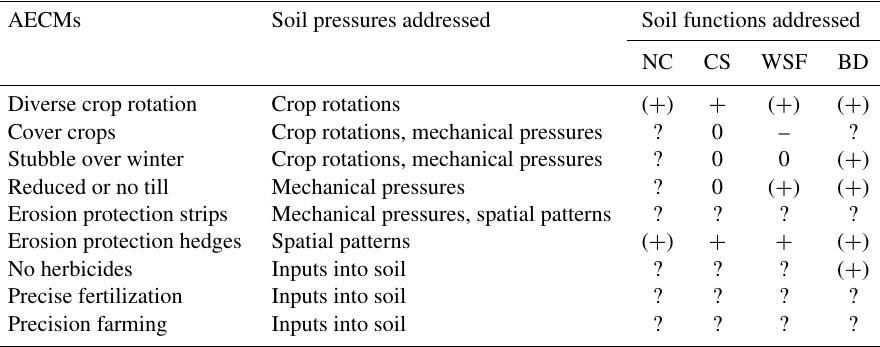
Table 3. German soil-related AECMs and their relation to soil pressures and soil functions. Note that soil pressures are based on Techen and Helming (2017). Soil functions: NC – nutrient cycling, CS – carbon storage, WSF – water storage and filtration, BD – biodiversity; “ + ” – positive effect on property strongly associated with soil function according to Vogel et al. (2019), “( + )” – positive effect on properties with minor association to soil function, “0” – no effect on properties associated with soil function, “ − ” – negative effect on properties associated with soil function, “?” – effect not